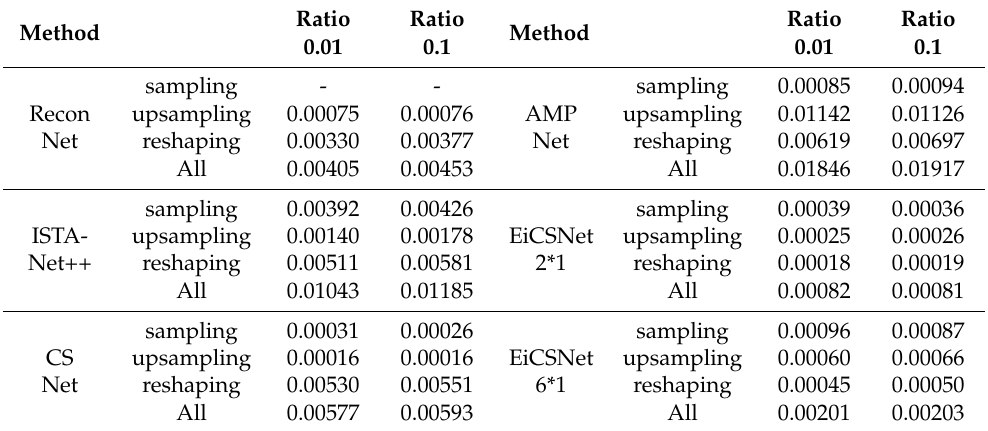
Table 7. The time consumption of the sampling, upsampling, and reshaping of different methods. All images were processed with B = 1.